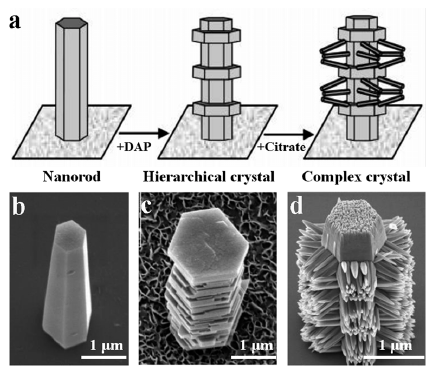
Figure 1. ( a ) Schematic illustration of the formation of ZnO complex crystals. ( b – d ) SEM images of samples at different formation steps (Reproduced with permission from [30], Copyright 2006, American Chemical Society). Crystals 2016 , 6 , 148